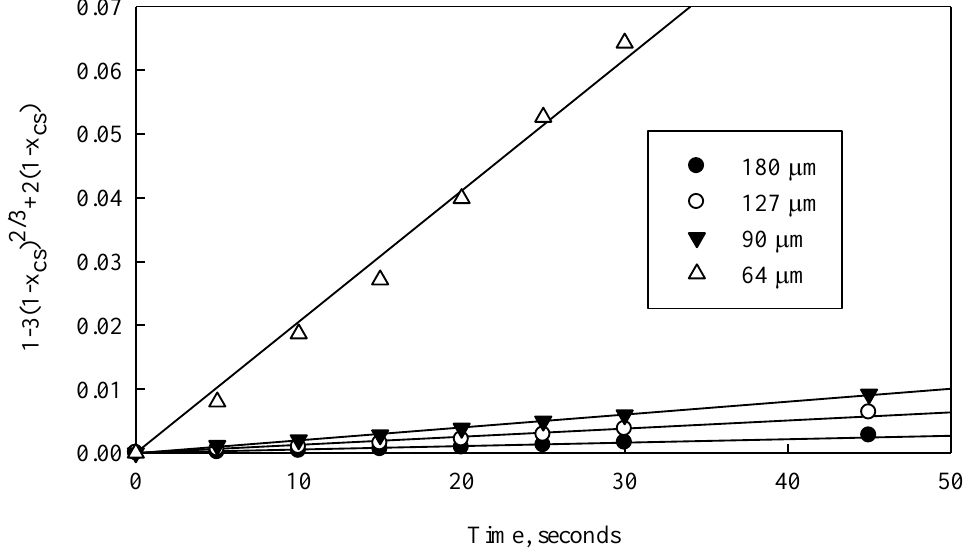
Figure 15. Slag leach kinetics for different particle sizes.